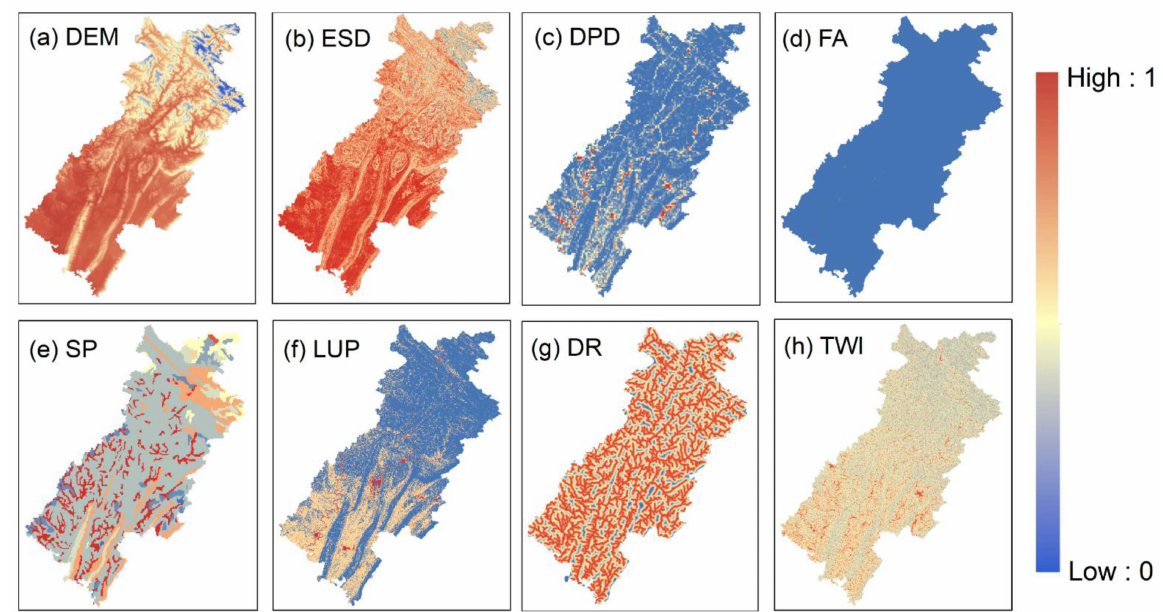
Figure 4. Spatial distribution of the topographic and hydrological flood hazard factors. The factors are standardized in the range from 0 to 1. ( a ) Digital Elevation Model (DEM); ( b ) Eleva- tion Standard Deviation (ESD); ( c ) Depression Point Density (DPD); ( d ) Flow Accumulation (FA); ( e ) Soil Permeability (SP); ( f ) Land Use (LU); ( g ) Distance to River (DR); and ( h ) Topographic Wetness Index